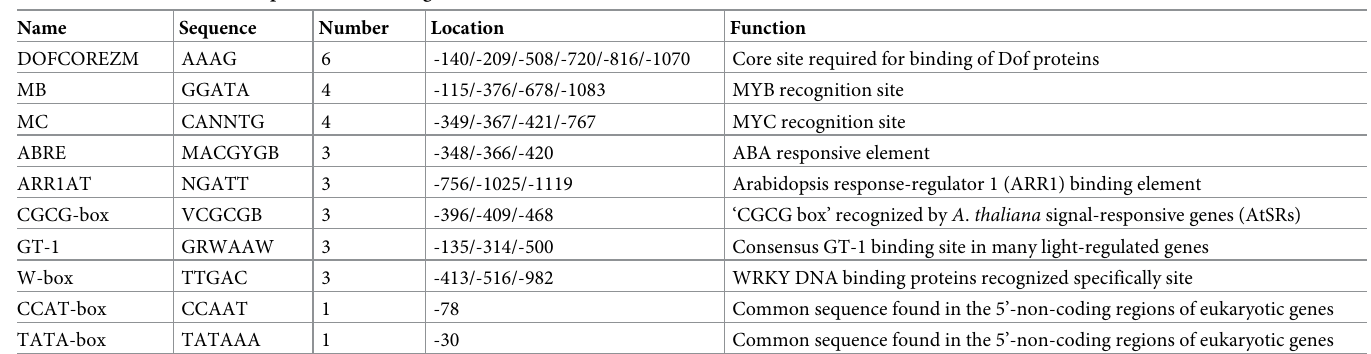
Table 1. Predicted AmDREB3 promoter cis -acting